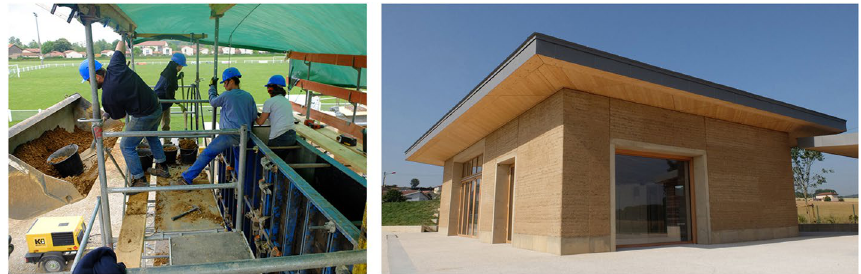
Fig. 6 “House for all” in the commune of Four, France, built in 2018 by students from the Grenoble School of Architecture as part of the design/ buildLAB supervised by Keith and Marie Zawistowski (Source: the